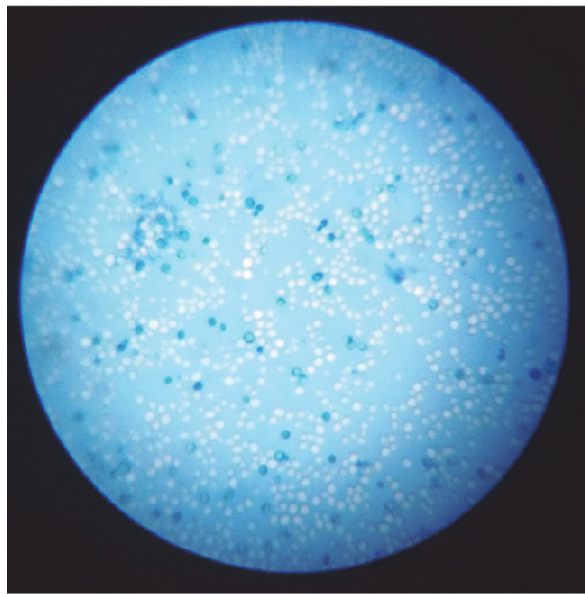
Figure 2. Antibacterial study of ligands and complexes by broth di- lution method in terms of MIC in μM.